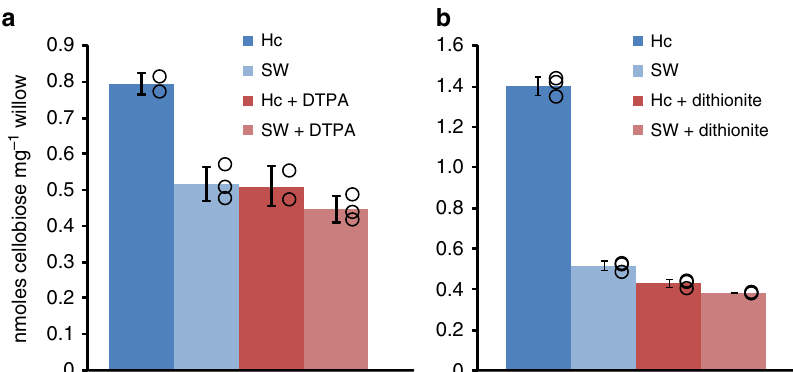
Fig. 5 Digestibility of willow following short hemocyanin pretreatments at room temperature. Digestibility of willow measured as release of cellobiose (nmoles) per unit biomass (mg) in sacchari fi cation reactions upon biomass pretreatment. Pretreatment of willow with hemocyanin in seawater (Hc, dark tones) or seawater alone (SW, light tones) without (blue colors) and with ( + , red colors) 50 m M DTPA (chelator) for 10 min ( a ) or 50 m M dithionite (reducing agent) for 20 min ( b ), followed by sacchari fi cation with CBH I from Hypocrea jecorina ( Hj CBH I). Hydrolysates were analyzed by HPAEC against cello-oligomer standards, and values normalized to reactions without CBH following pretreatments to account for any remaining cellulase activity derived from the hemocyanin preparation. Circles represent sample values and bars sample mean ± SD, N = 3 ( N = 2 for Hc